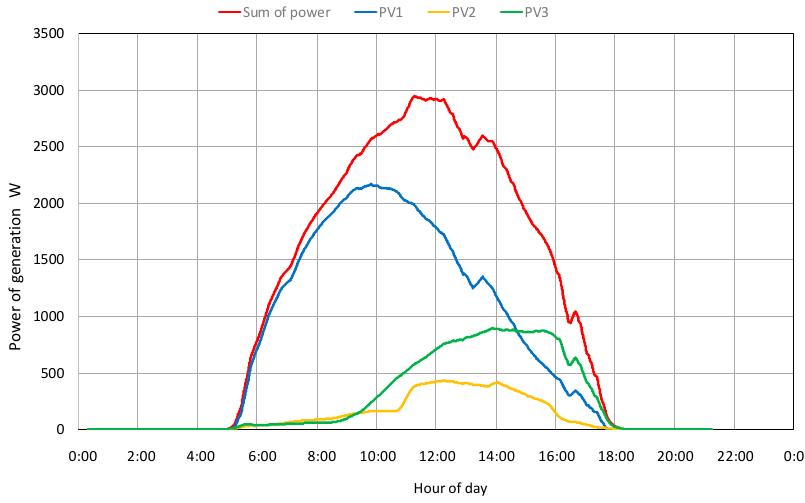
Figure 5. An example of daily PVS generation on 24th May 2019.